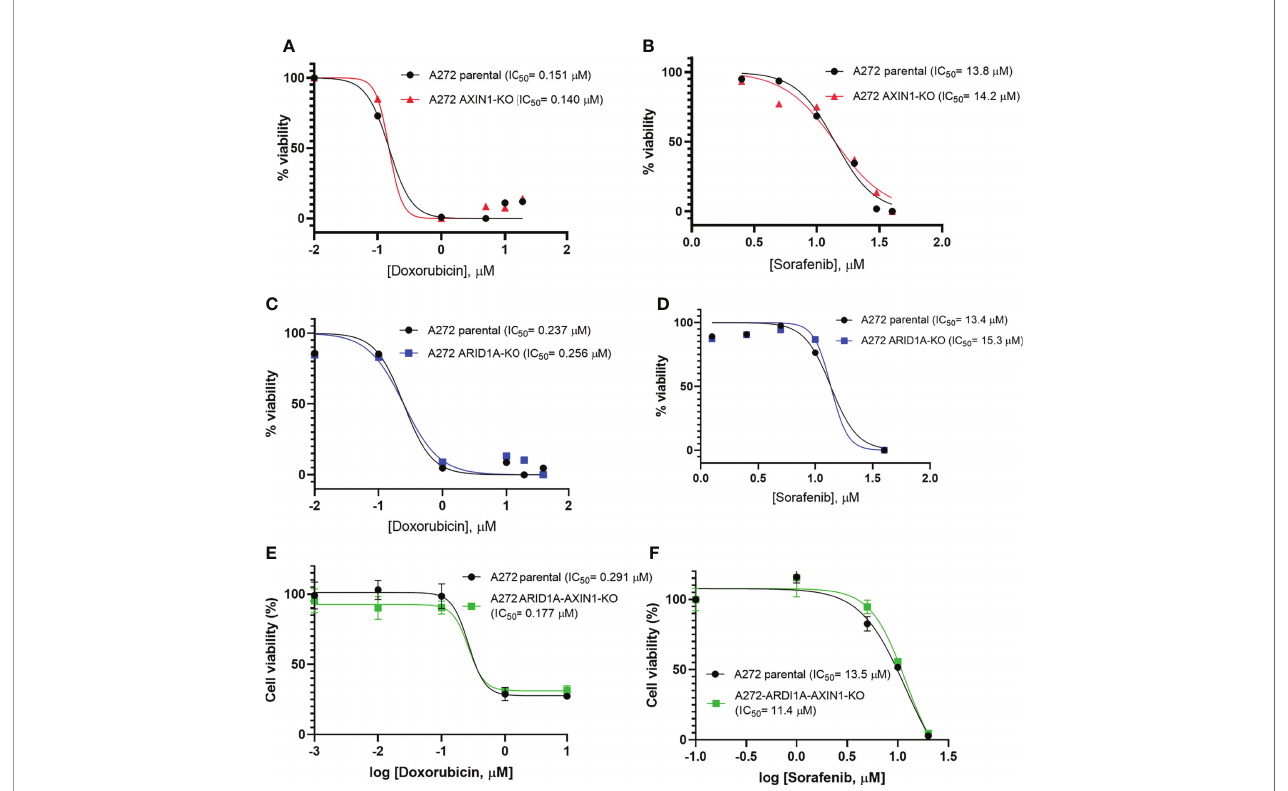
FIGURE 7 | Knockout of ARID1A and/or AXIN1 does not alter the susceptibility of porcine HCC cells to sorafenib nor doxorubicin. A272 porcine HCC cells were incubated with serial dilutions of doxorubicin or sorafenib and viability was measured after 48 hours. Relative cell viability is plotted against log concentration of doxorubicin (A, C, E) or sorafenib (B, D, F) . No signi fi cant difference was detected in log half-maximal inhibitory concentration (IC 50 ) of parental A272 cells as compared to AXIN1 KO (A, B) , ARID1A KO (C, D) , or ARID1A-AXIN1 KO (E, F) cells at p < 0.05. IC 50 values are shown in the fi